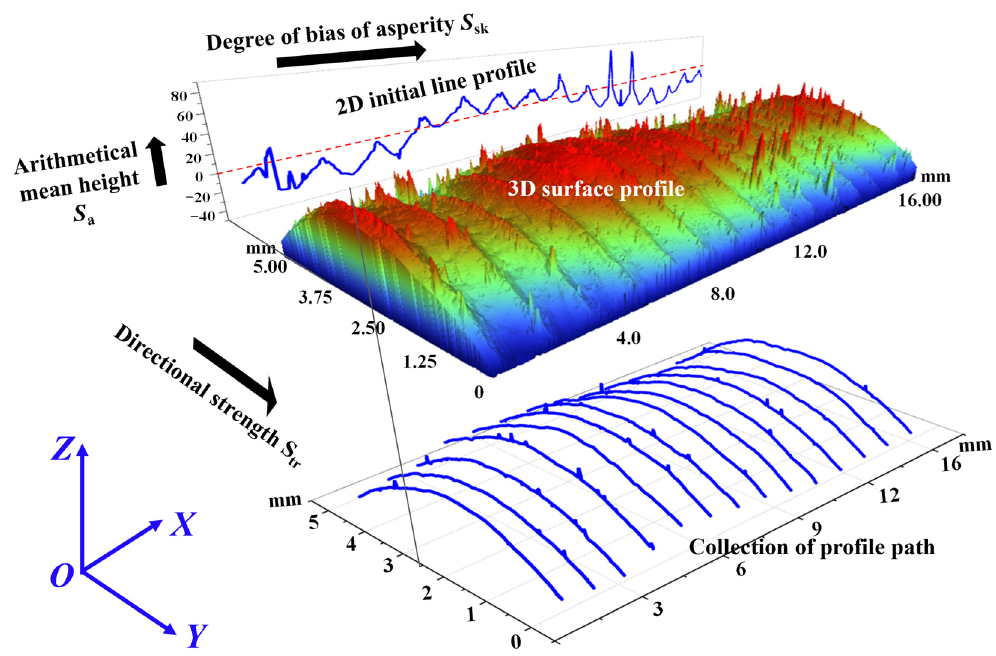
Figure 6. Equivalent forming method of surface profile of EHLA coating.